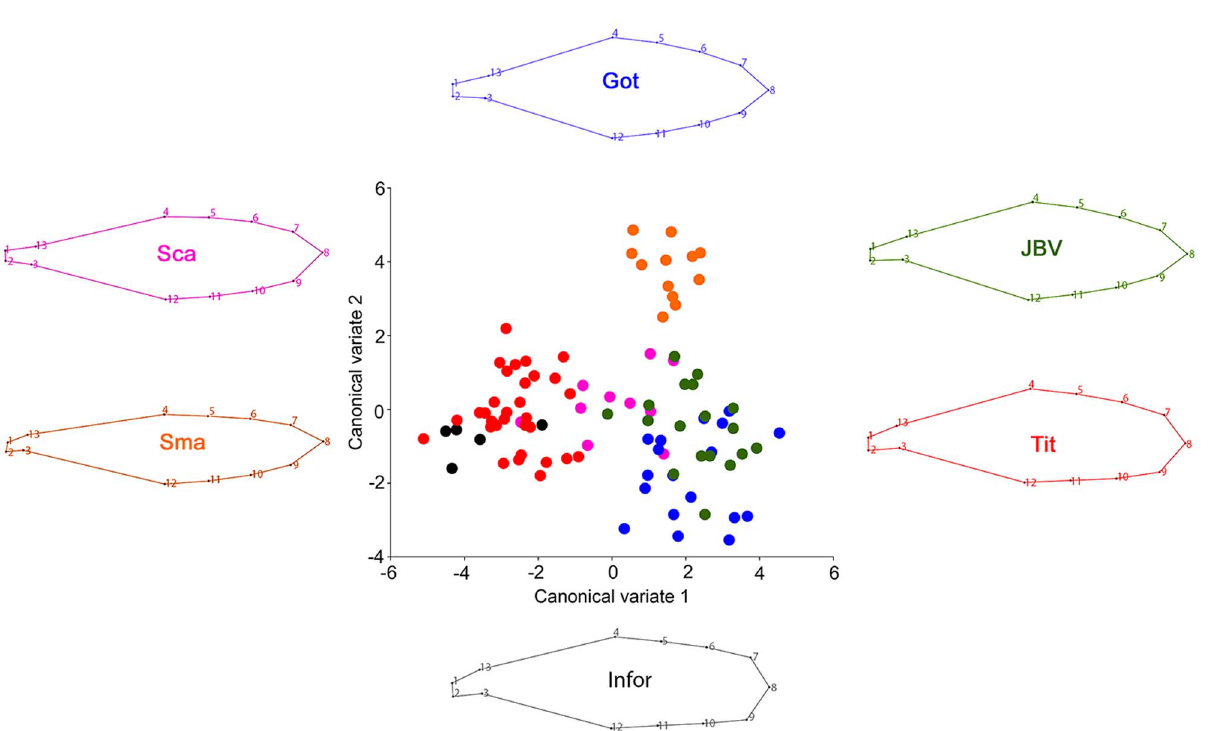
Fig. 2. Canonical variate analysis of the wing comparing the different Sophora toromiro lines and the two out-groups, Goteborg (Got), INFOR, Jardin Botanico Vin˜a (JBV), Titze (Tit), Sophora macrocarpa (Sma), Sophora cassioides (Sca). The wireframe represents the average shape of each one of the analyzed